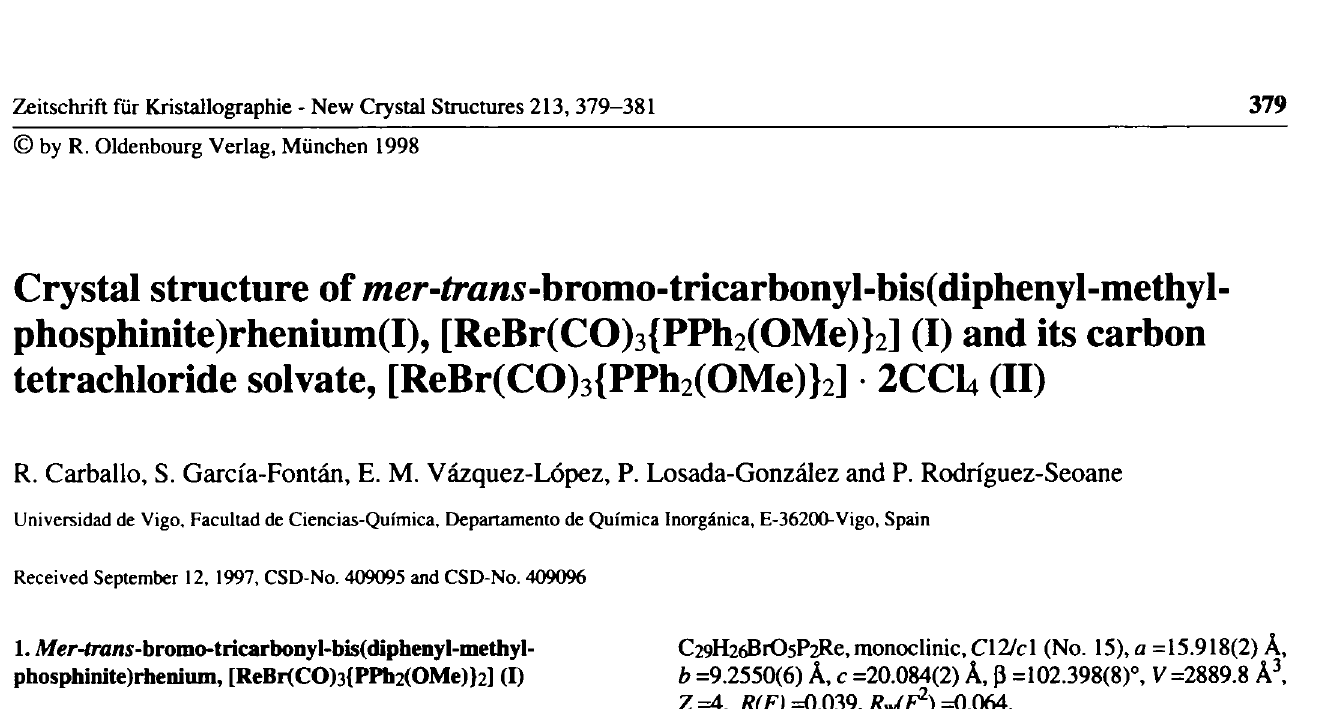
Table 1. Parameters used for the X-ray data collection Crystal: